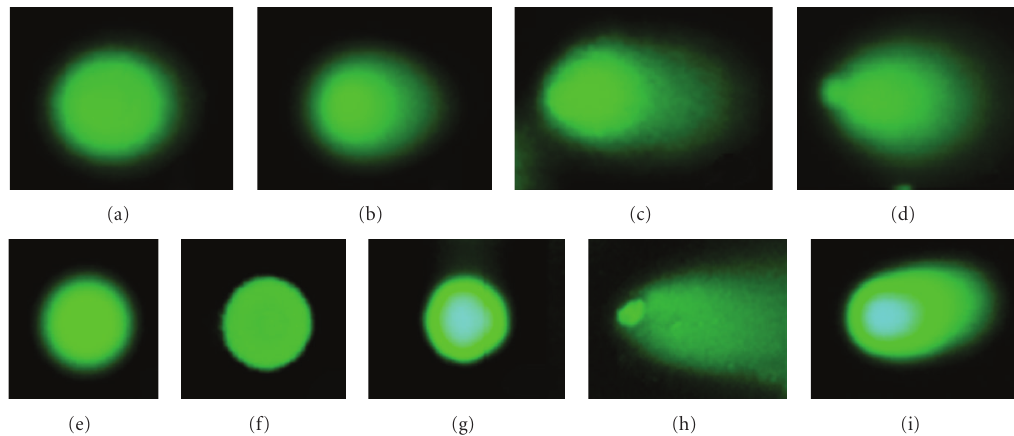
Figure 3: Images of SCGE assays. Controls: (a) Undamaged control cell, (b)–(d) Control cells with variable amount of DNA damage. LNCap Cells: (e) No compound + No UV; (f) No compound + UV; (g) 3 (50 μ M) + No UV; (h) 3 (50 μ M) + UV; (i) 3 (10 μ M) + UV. All UV irradiations were carried out for 10 minutes.